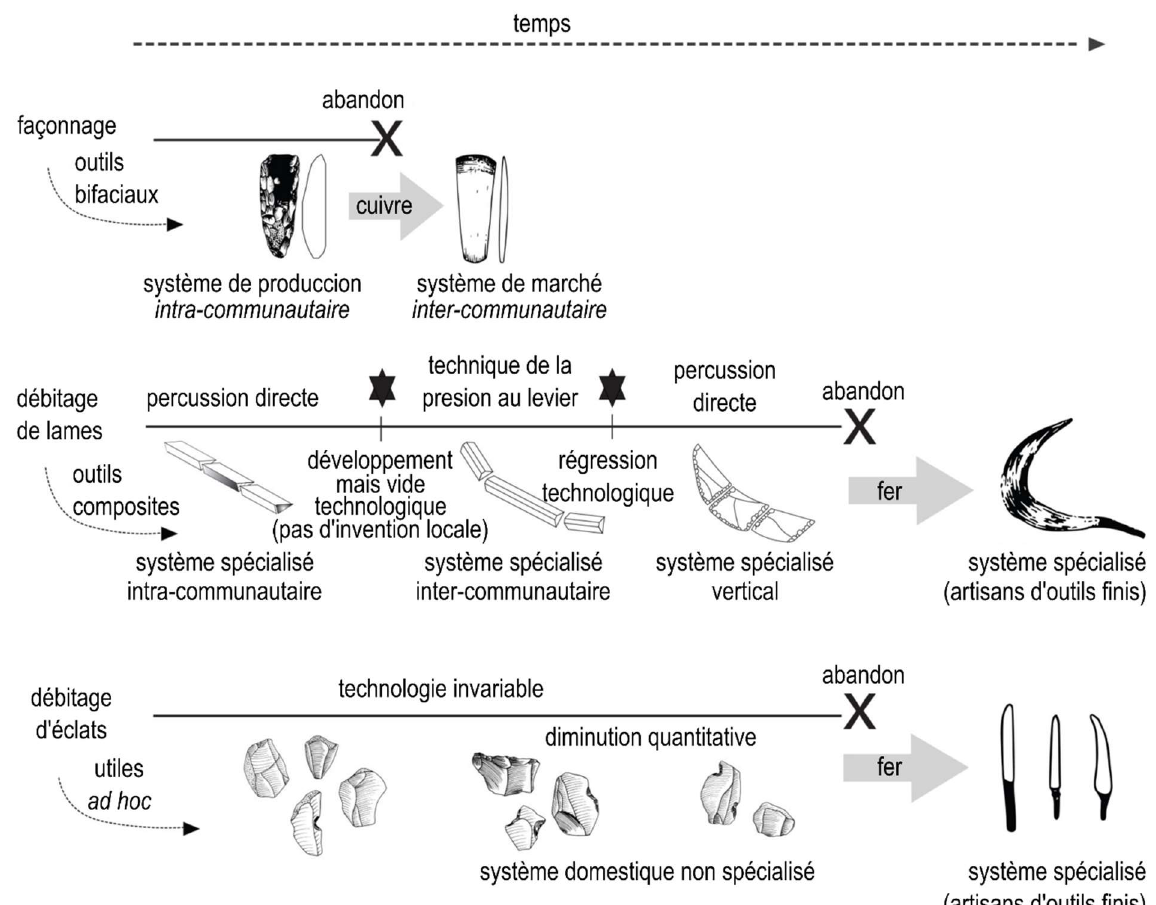
Figure 17. Trois lignées de production différentes (façonnage, débitage laminaire, débitage des éclats) qui ont été remplacées par des lignées d'objets métalliques, suivant des trajectoires et des rythmes différents (Manclossi et al. 2019: fig.